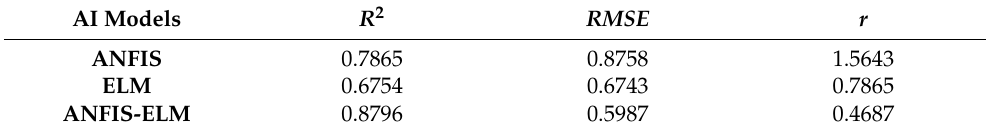
Table 1. Regression results of the models in test